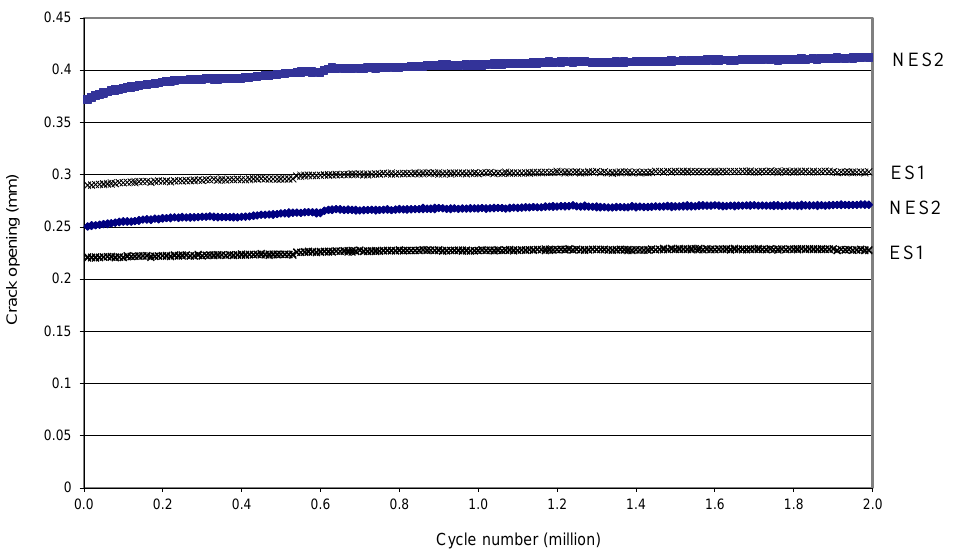
Figure 9. Evolution of crack opening extremes during fatigue tests of NES2 and ES1.